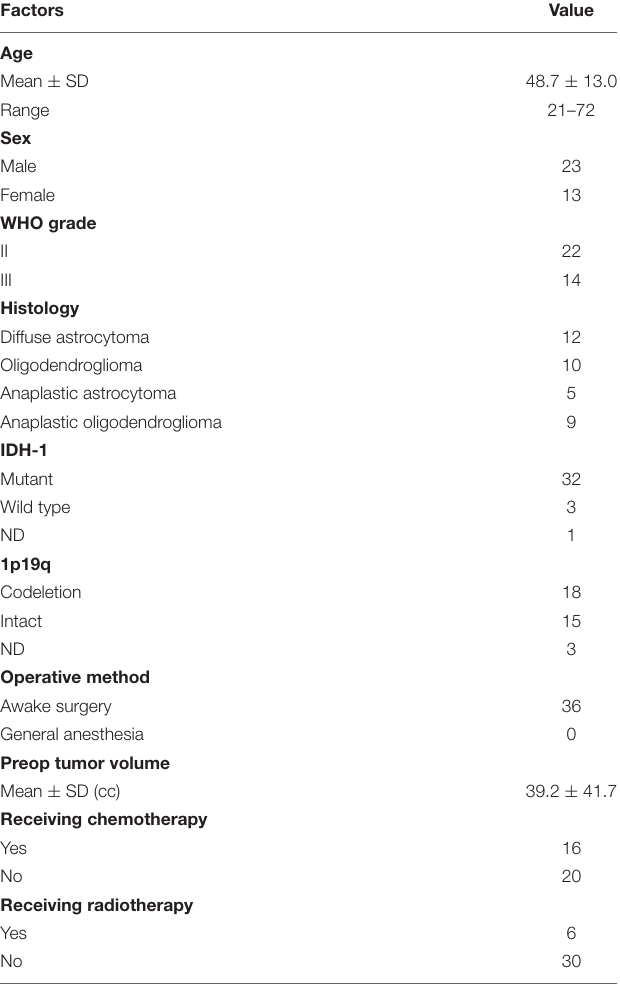
TABLE 1 | Demographic and clinical characteristic of